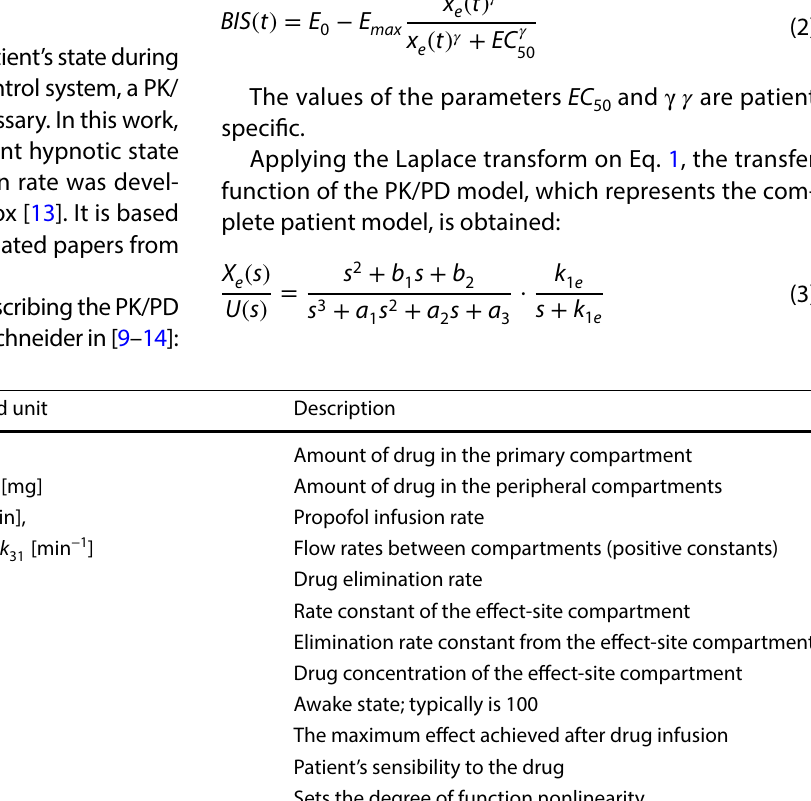
Sets the degree of function The BIS value can be calculated from the concentration of the effect-site compartment by using the nonlinear Hill